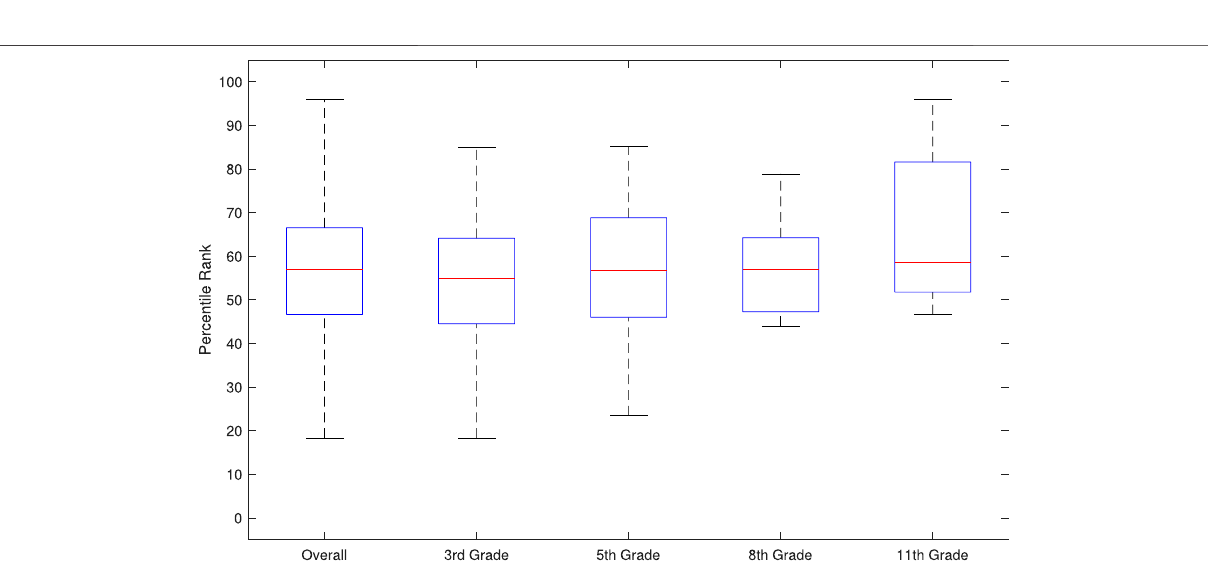
Frontiers in Built Environment |